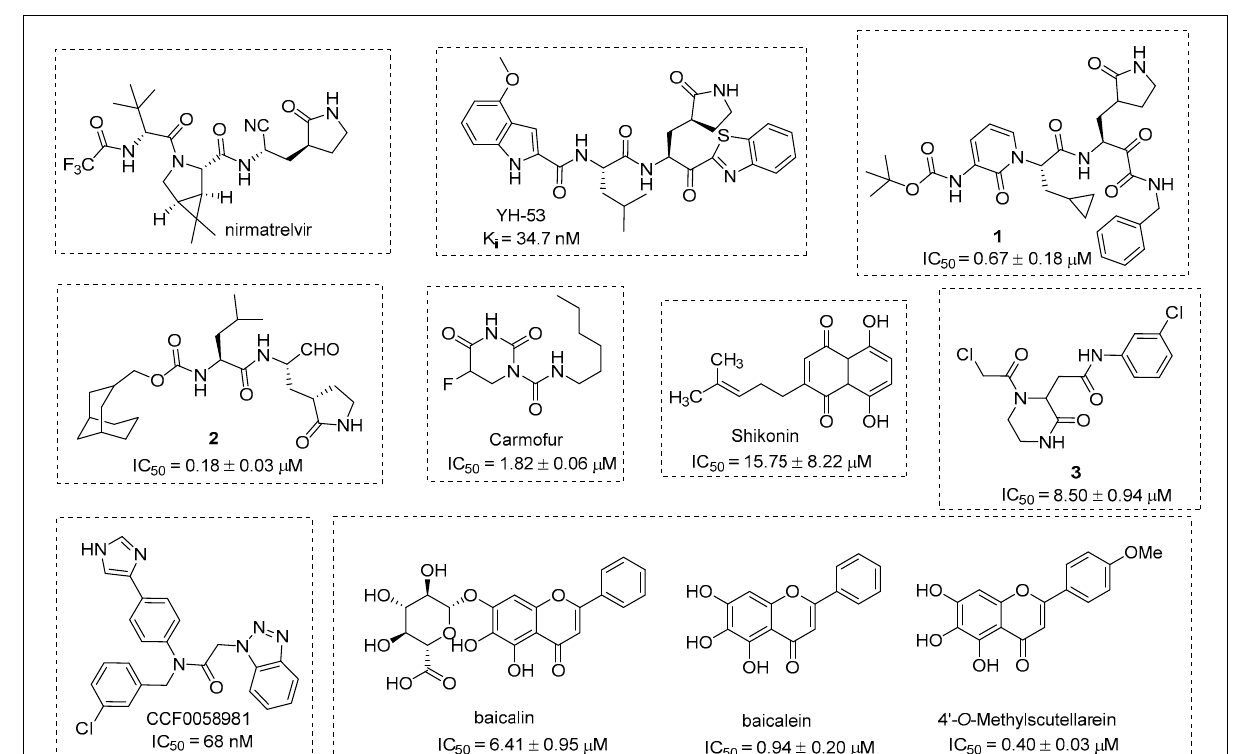
Figure 1. SARS-CoV-2 3CL pro inhibitors.